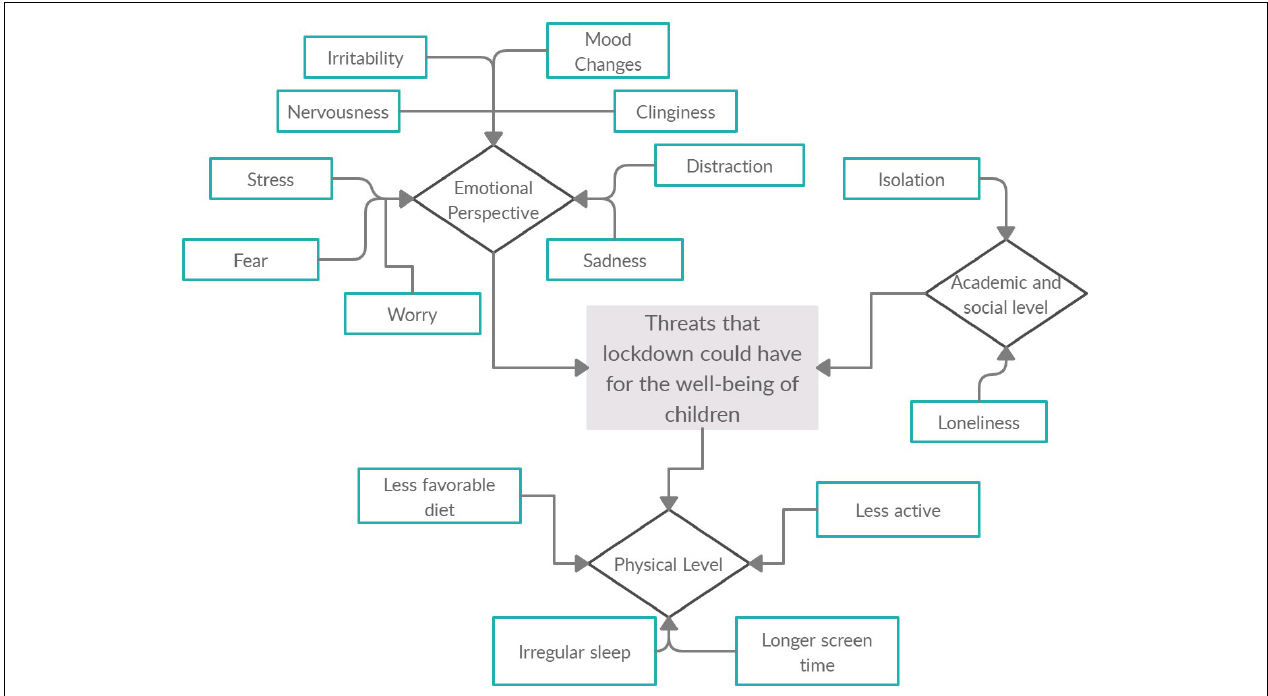
FIGURE 1 | Summary of threats that lockdown could have for the well-being of